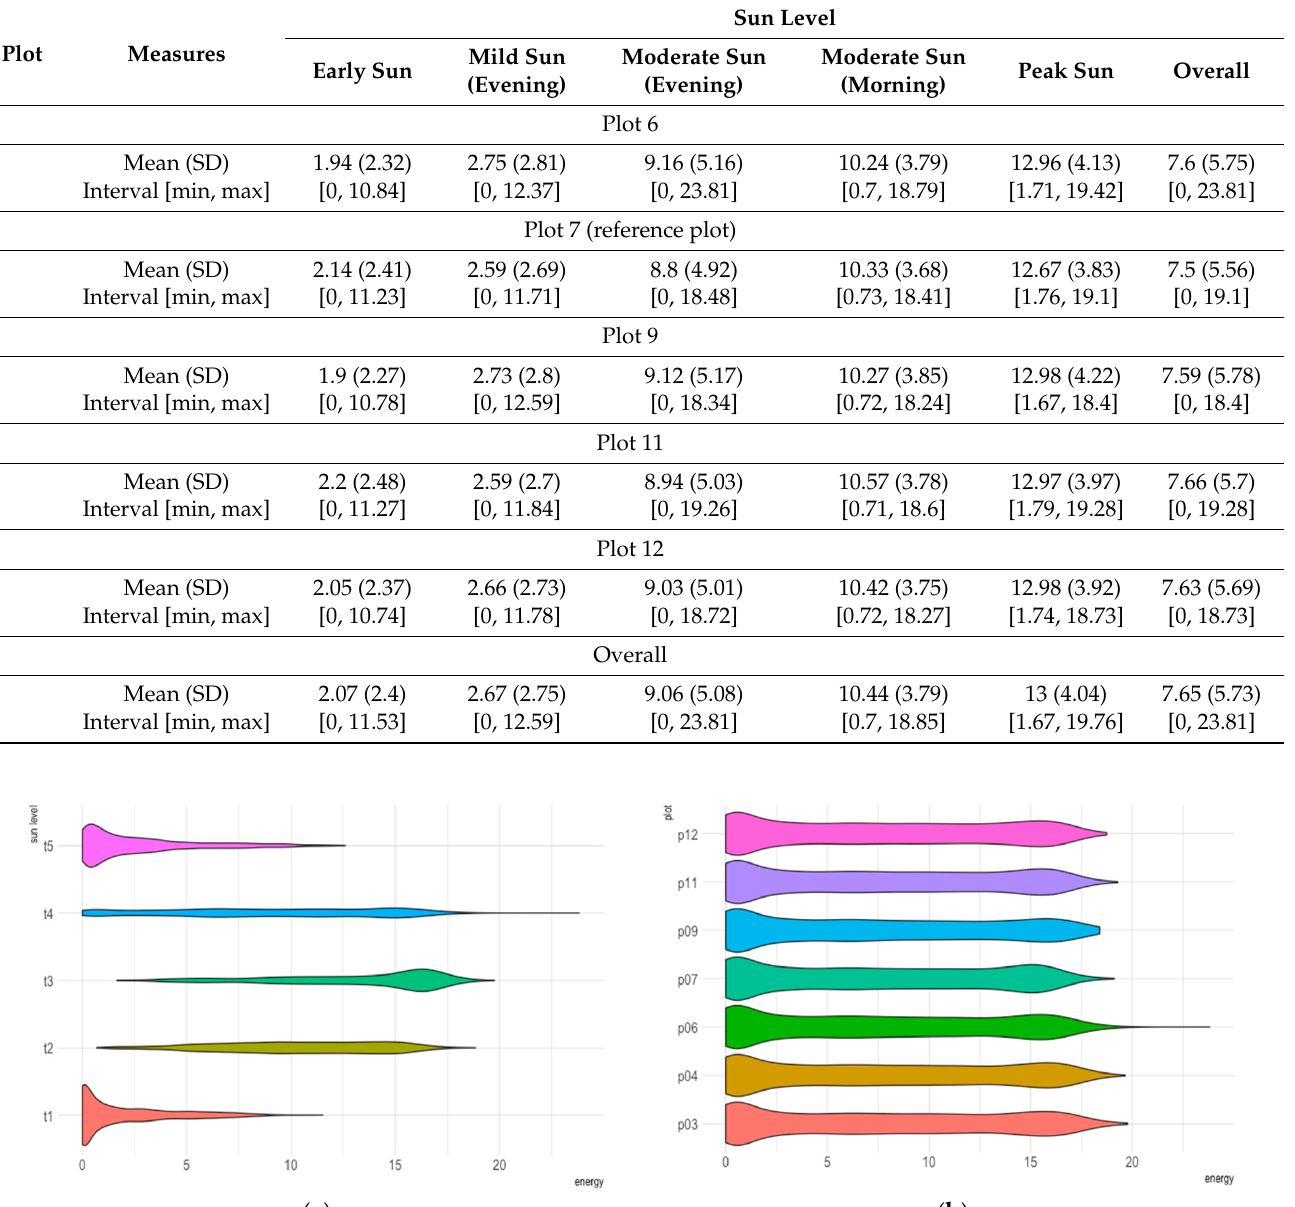
( b ) Figure A2. Equal variance and normality assessments on energy at di ff erent sun levels. ( a ) Residu- als vs. fi tt ed. ( b ) Normal Q-Q.